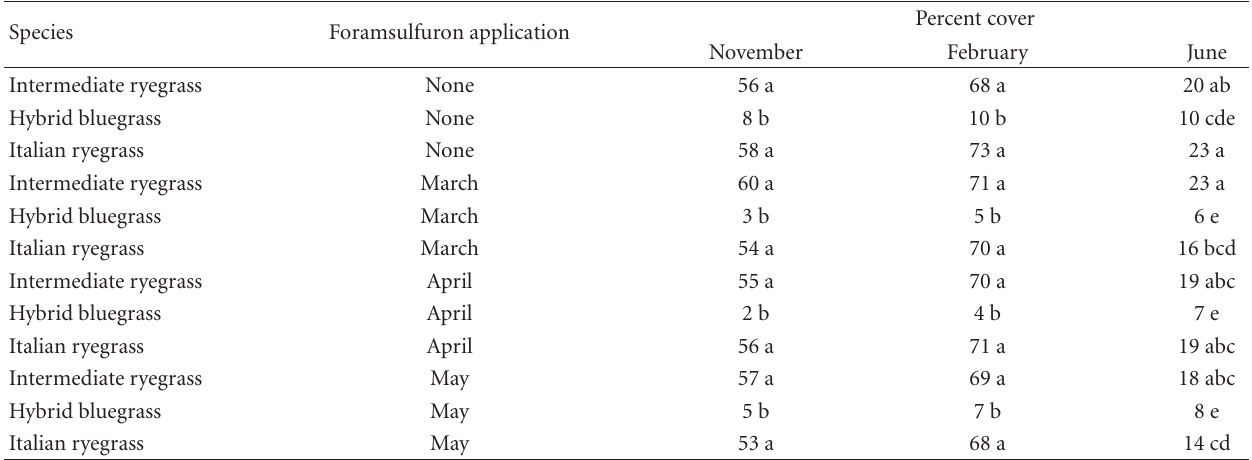
Table 5: Percent cover of overseeded species as a ff ected by foramsulfuron application timing in 2005 for the second experiment. a